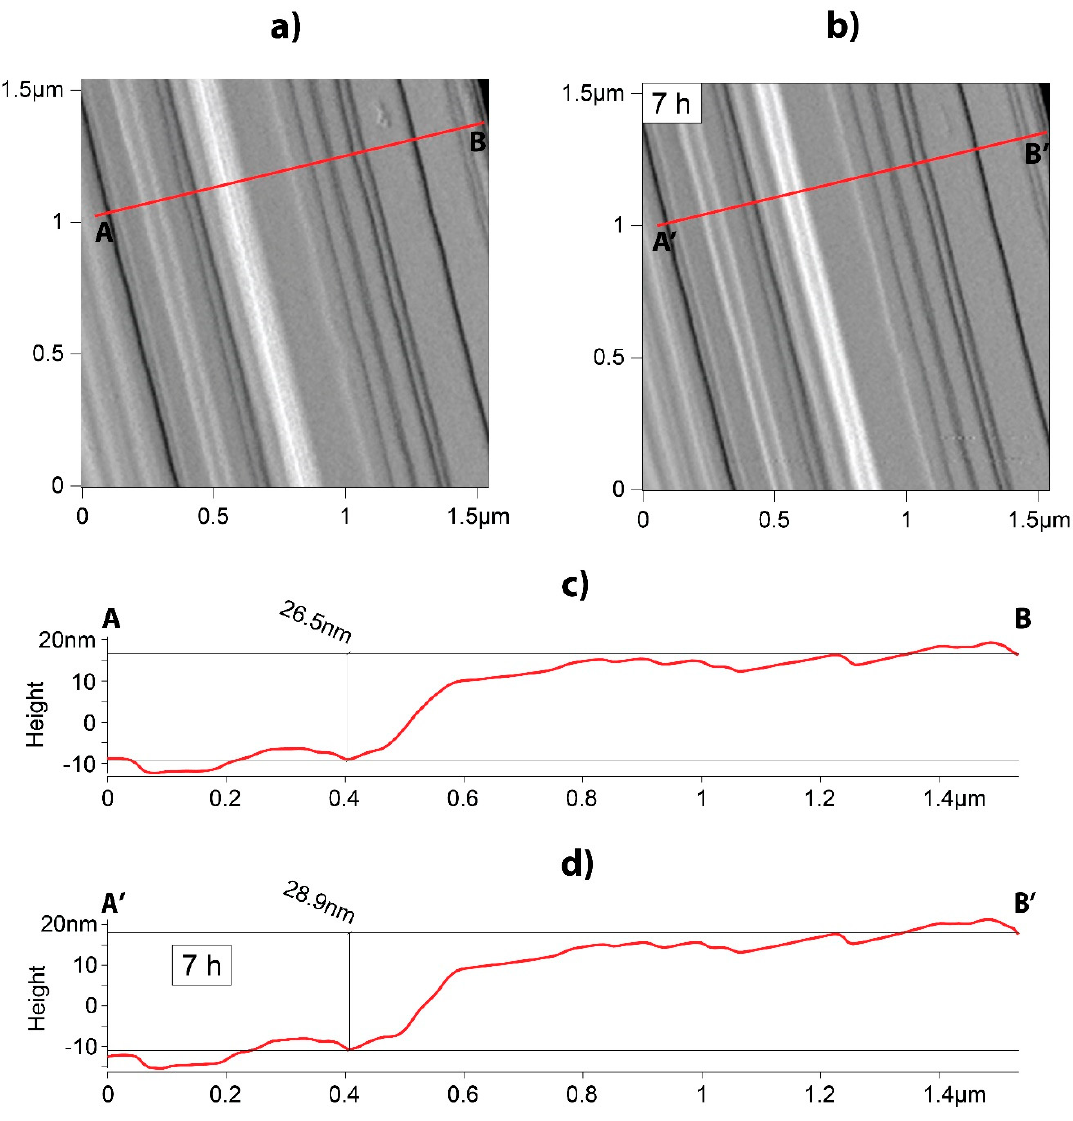
Figure 7. Amplitude retrace AFM images of the same area of erionite surface at 25 °C: ( a ) in water and ( b ) after 7 h of interaction in ALF solution (pH 4.15). Corresponding profiles of AB section ( c ) and A’B’ section ( d ).